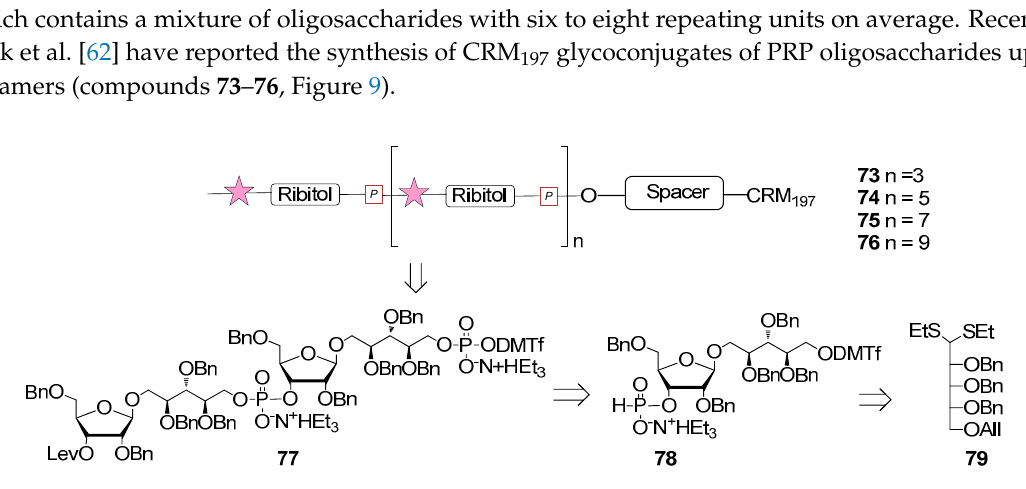
Figure 9. Haemophilus influenzae type b PRP oligosaccharides reported in [63].